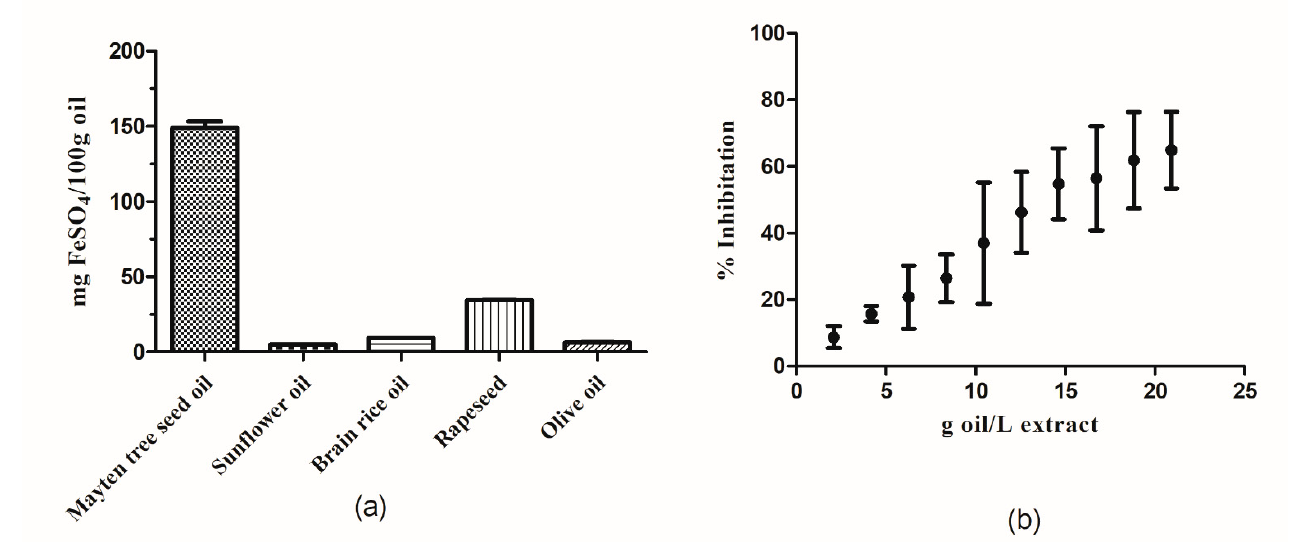
Figure 3. ( a ) Ferric reducing antioxidant power (FRAP) values for Mayten tree seed oil, sunflower oil, brain rice oil, canola oil, and olive oil. (Adapted with permission from Szydłowska-Czerniak, A. et al. [67], Copyright 2008 Elsevier); ( b ) Inhibition of the 2,2-diphenyl-1-picrylhydrazyl (DPPH) radical by Mayten tree seed oil. Values are represent as mean ± standard